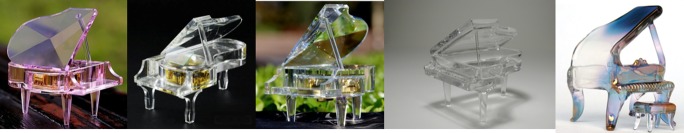
Five additional glass Pianos.VGG-19 incorrectly classified each of these five images despite correctly classifying the glass piano shown in Fig 11.